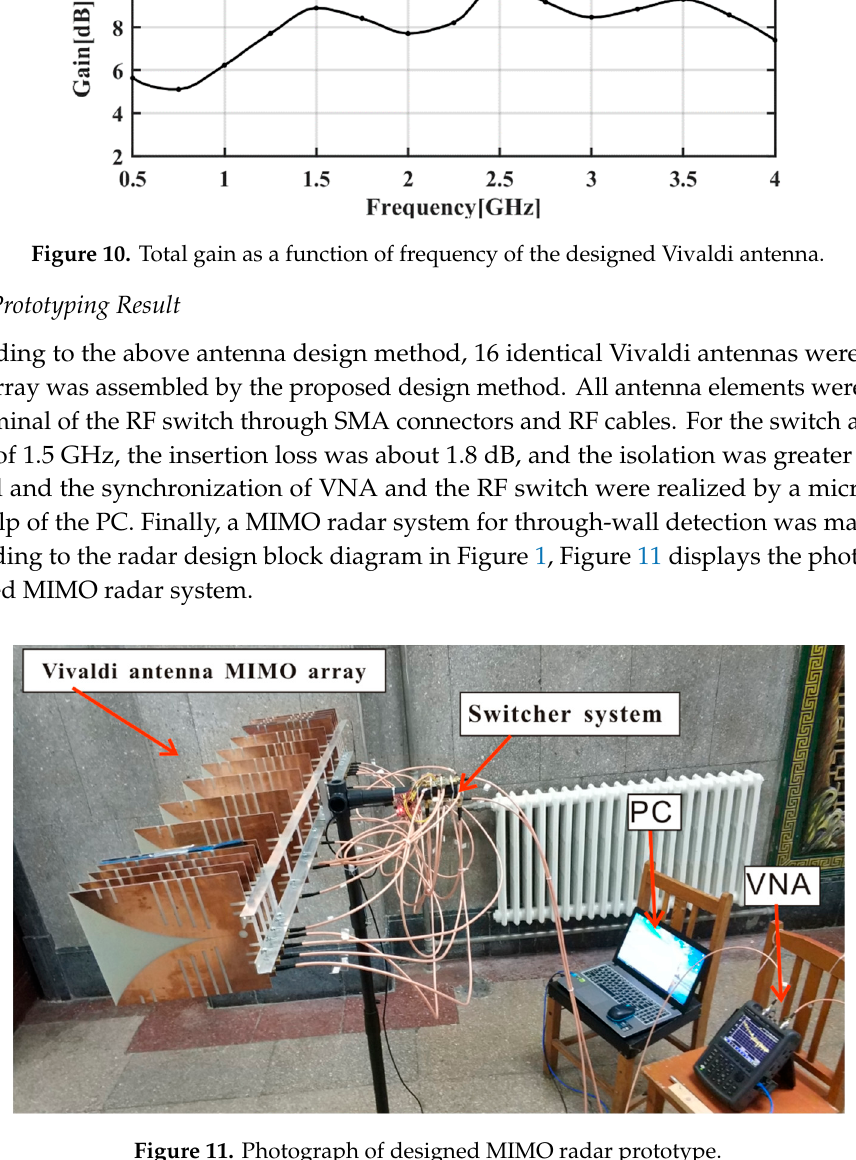
Figure 11. Photograph of designed MIMO radar prototype.